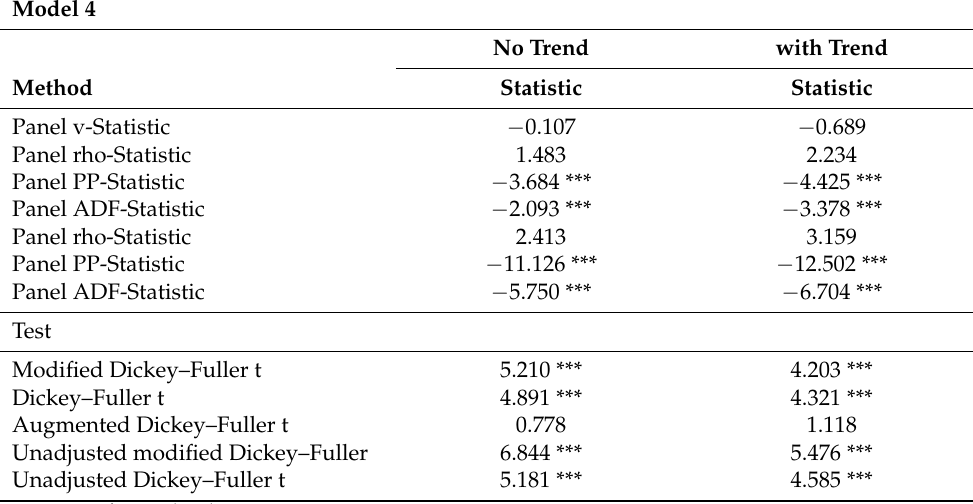
Table 11. Panel cointegration tests. Pedroni panel cointegration test and Kao Residual Cointegration for model 4.